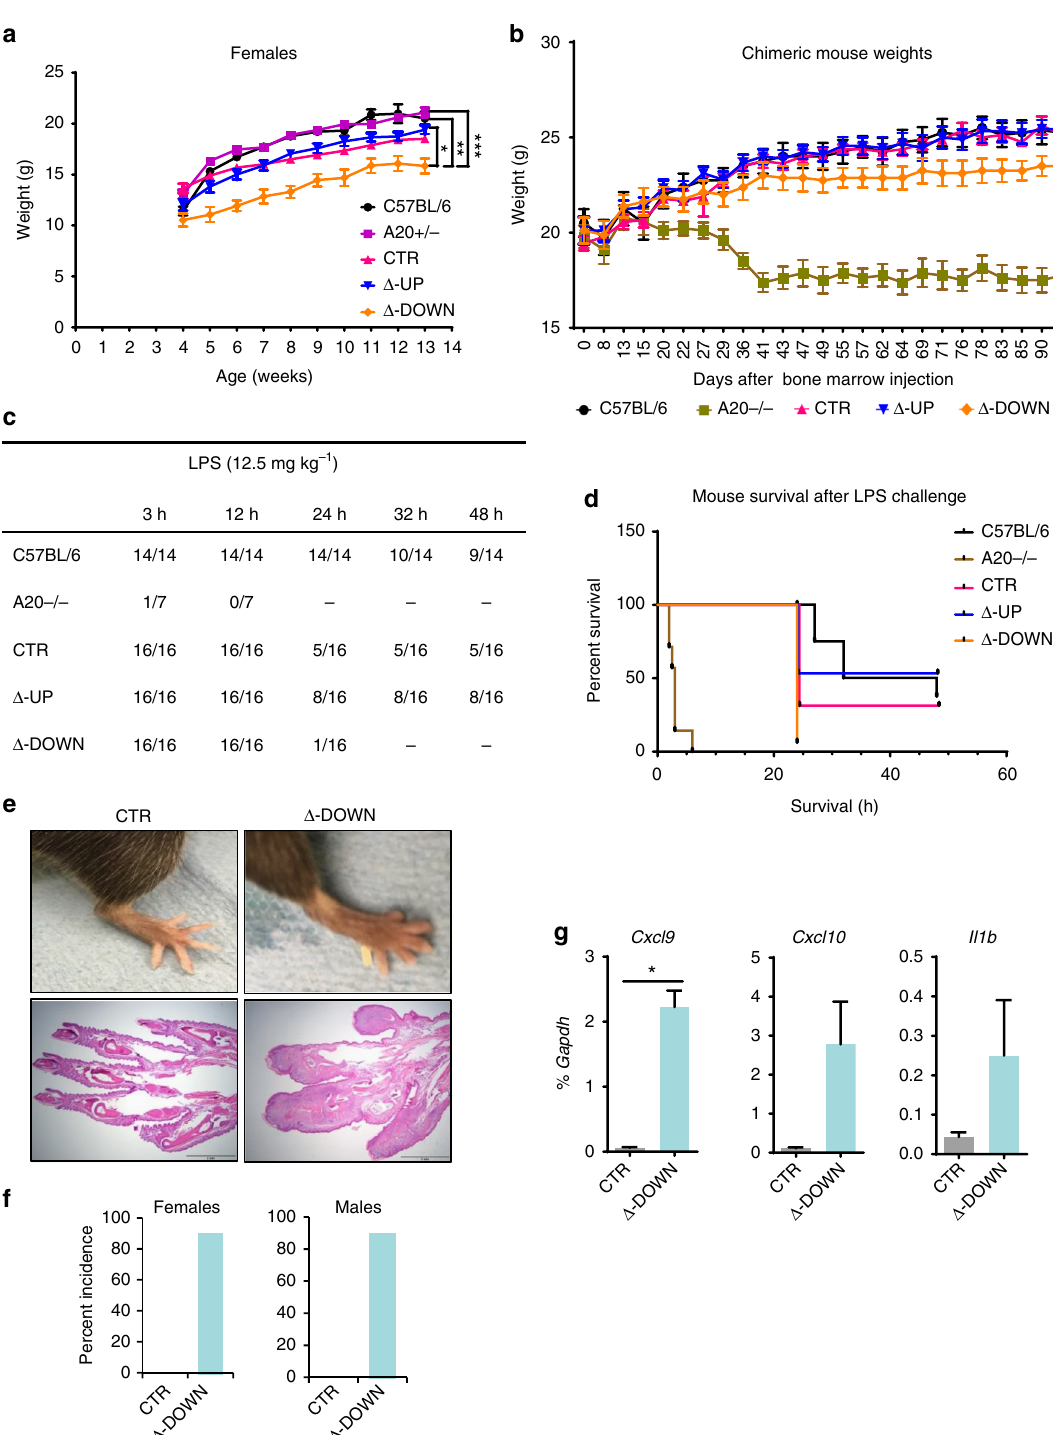
Fig. 3 Downstream enhancers prevent development of in fl ammatory pathology and autoimmunity. a Growth curves of BAC transgenic and control mice. n ≥ 10 per Tg group. b Growth curves of C57BL/6 mice chimeric for bone marrow from BAC transgenic or Tnfaip3 − / − mice. n = 9 per group. Error bars indicate mean ± s.e.m., statistical signi fi cance was determined using one-way ANOVA followed by Tukey ’ s multiple comparison test, * P < 0.05; ** P < 0.01; *** P < 0.001. c , d Survival data for LPS-challenged mice shown in tabulated form ( c ) or as Kaplan – Meier plot ( d ). Data pooled from two experiments, n = 16 for transgenic mice. e Photographs of hind paws of CTR and Δ -DOWN mice at the age ≥ 6 months (top). Photomicrographs of H&E-stained sections of paws and digits; scale bars, 2 mm (bottom). f The cumulative incidence of arthritis in CTR ( n = 5 for females and 7 for males) and Δ -DOWN ( n = 8 for females and 5 for males) mice starting at 6 months and monitored up to 12 months of age. g mRNA levels of Cxcl9 , Cxcl10 , and Il1b in cells isolated from hind paws of CTR ( n = 3) and Δ -DOWN ( n = 3) mice at the age ≥ 6 months. Results are shown as mean ± s.e.m. * P < 0.05, paired t